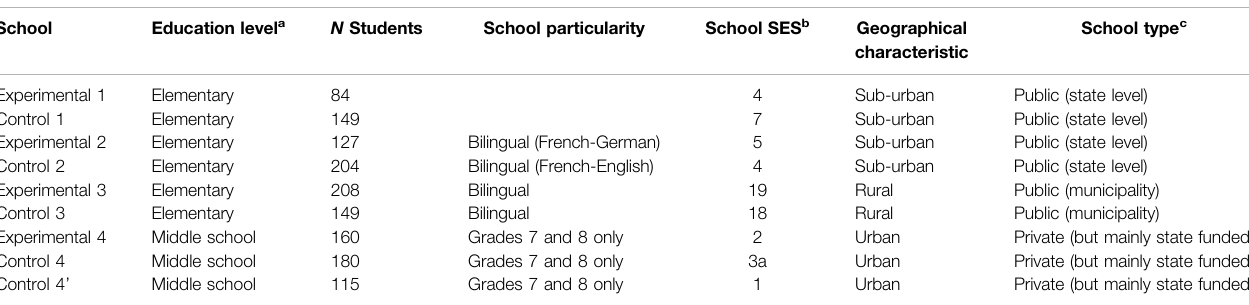
TABLE 2 | Characteristics of participating